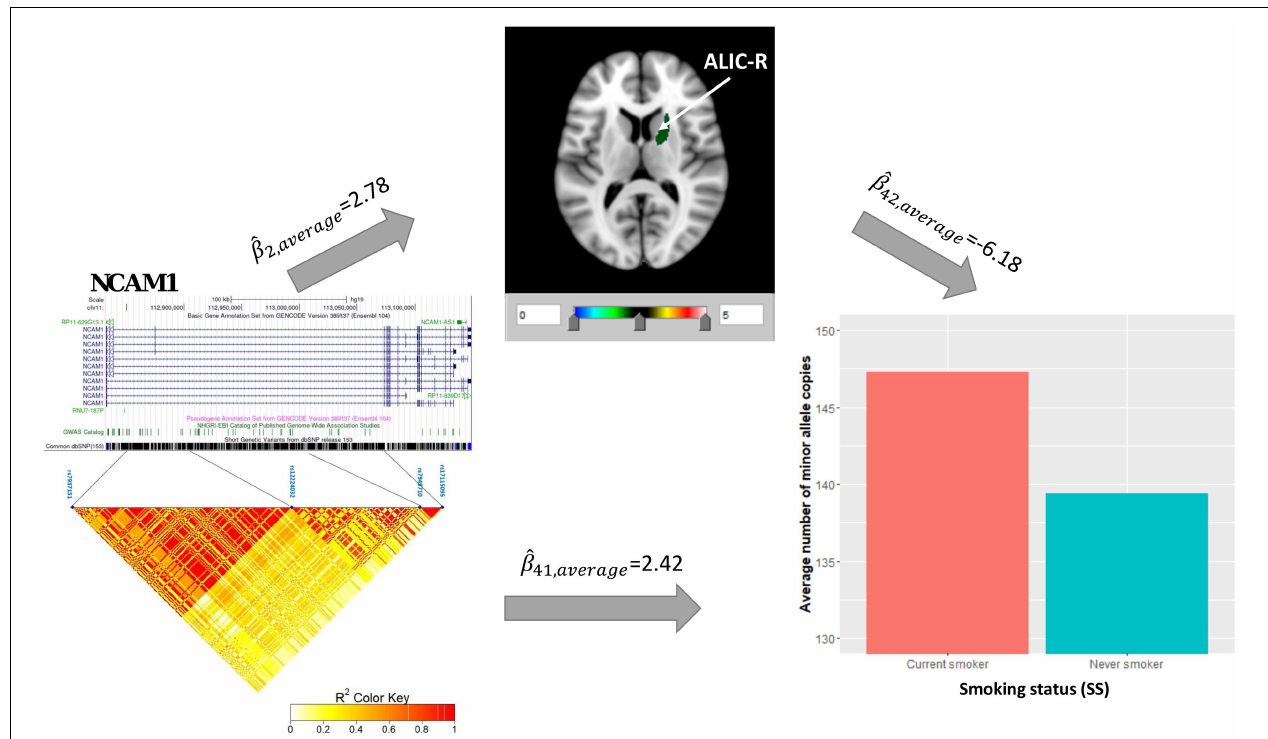
FIGURE 3 | ALIC-R mediates the genetic effects of 244 variants located within NCAM1 (chr11: 112,835,024–113,060,660) on SS. Exact locations of the 244 variants on the genome and their pairwise LD scores are shown. Bar chart shows the average number of minor allele copies for 244 variants among two groups of subjects to describe the current smokers have more copies of minor alleles than never smokers. Colors in the brain images denote the average –log10( p -value) of FA association with the 244 variants. The direct ( ˆ β 41 ) and indirect effects ( ˆ β 2 ˆ β 42 ) are averaged over all SNPs. ALIC-R, right tract of the anterior limb of the internal capsule; LD, linkage disequilibrium; FA, fractional anisotropy; SNPs, single-nucleotide